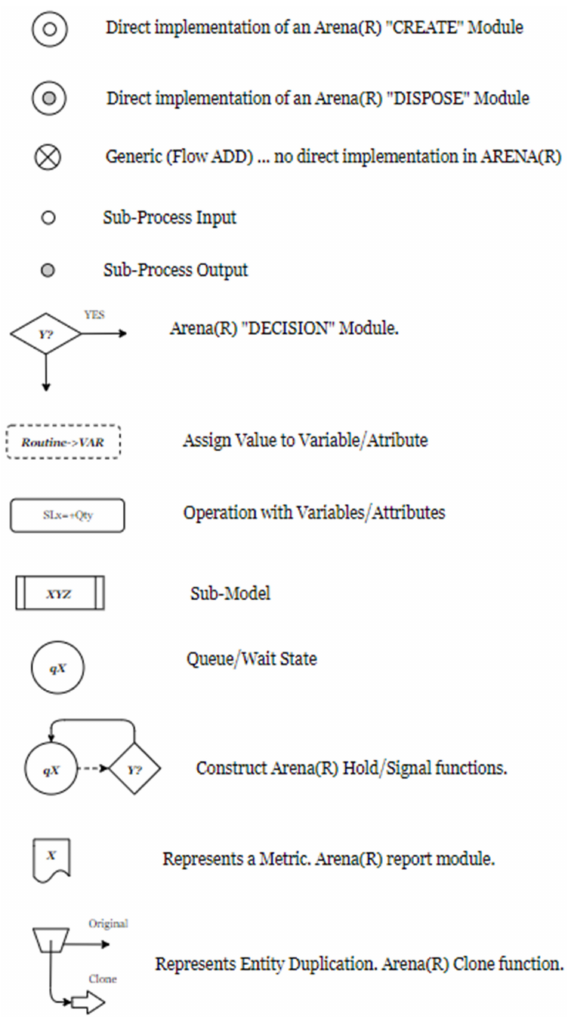
Figure 14. Pseudo-code in place of the Arena ® graphical